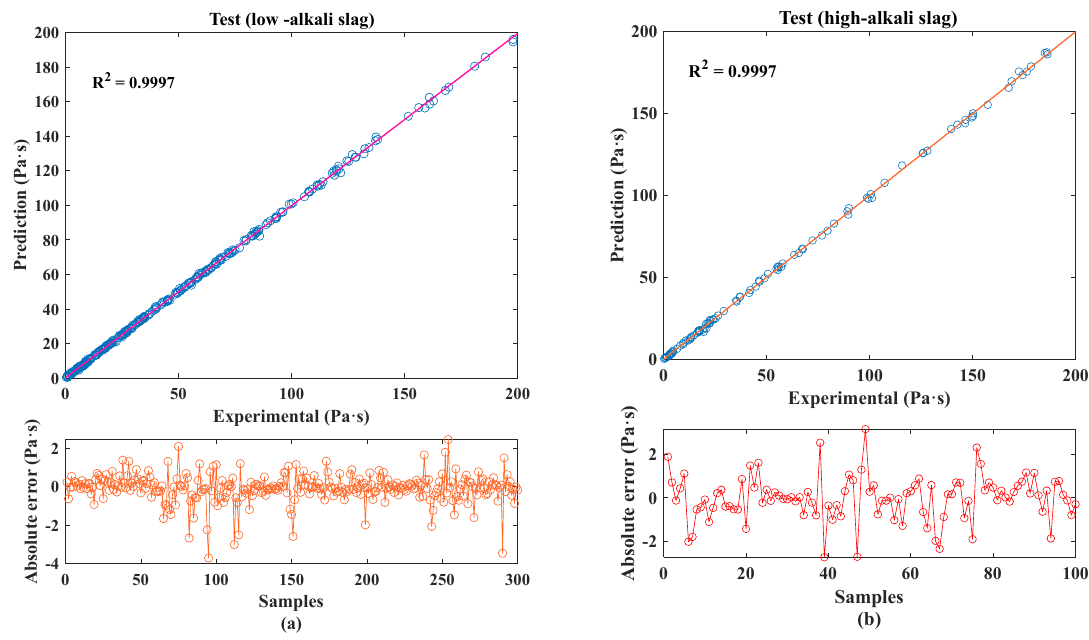
Figure 1. Viscosity prediction results: ( a ) low ‐ alkali slag, ( b ) high ‐ alkali slag.